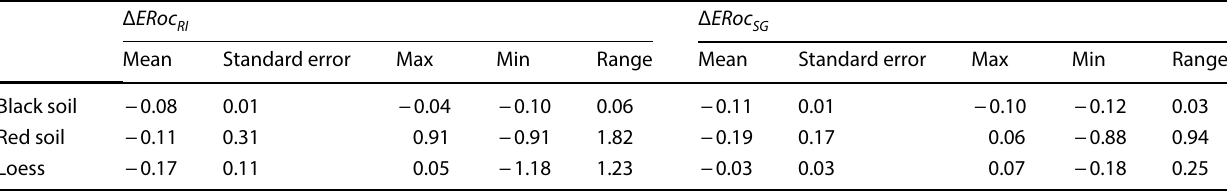
Table 4 Effects of rainfall intensity and slope gradient on ERoc for black soil, red soil and loess